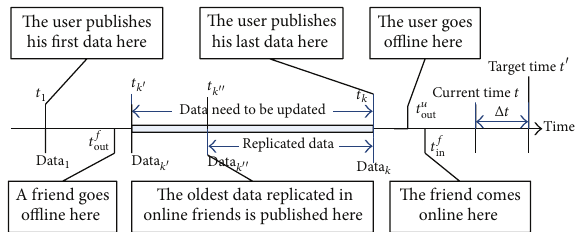
Figure 1: The illustration of the data availability problem.